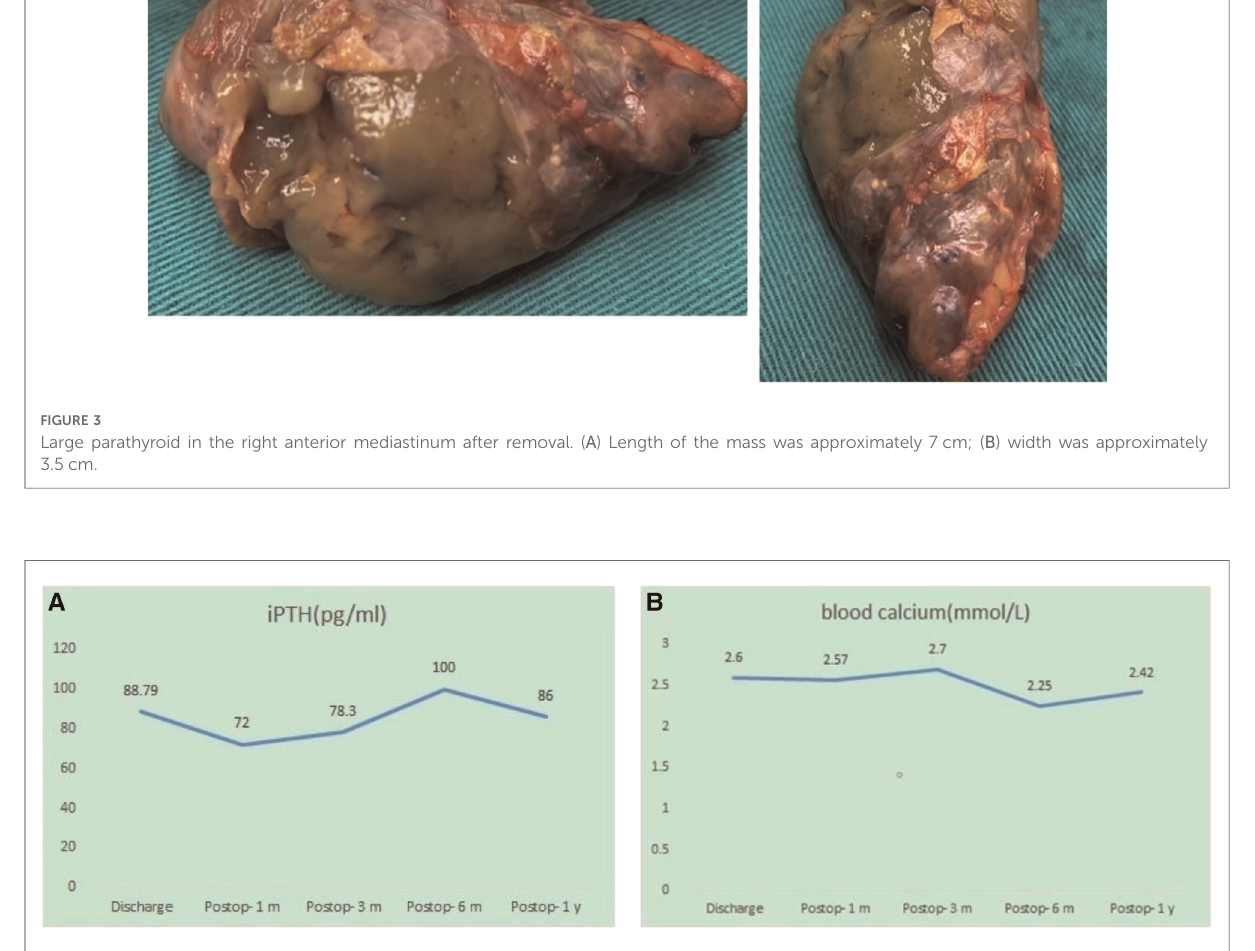
FIGURE 4 Results of the 1-year follow-up. ( A ) iPTH level; ( B ) blood calcium